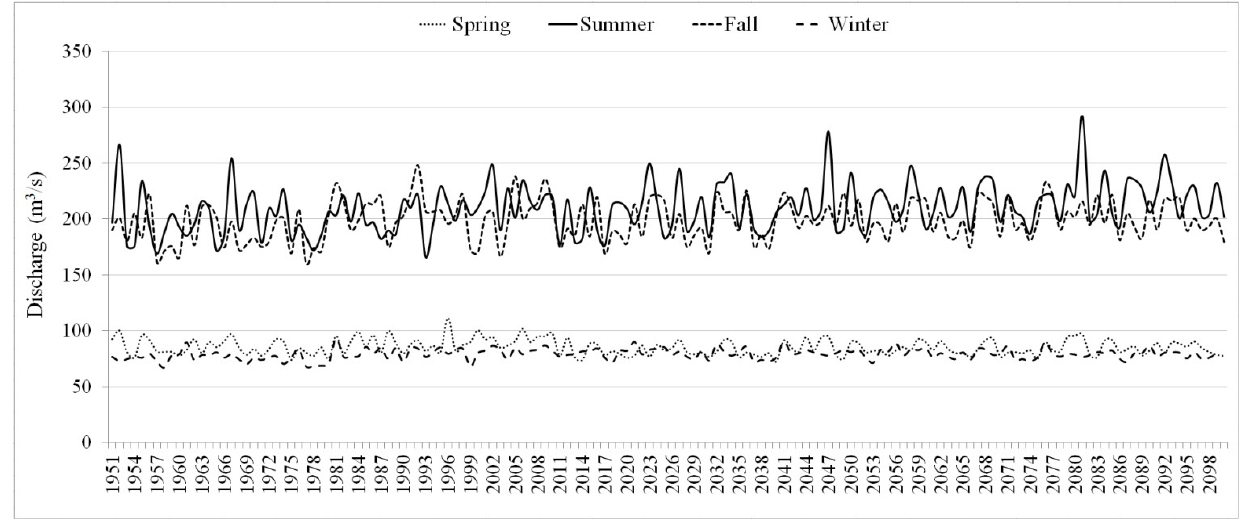
Figure 10. Historical and projected seasonal discharge from 1951 to 2100 (average of all GCMs and IPCC-SRES